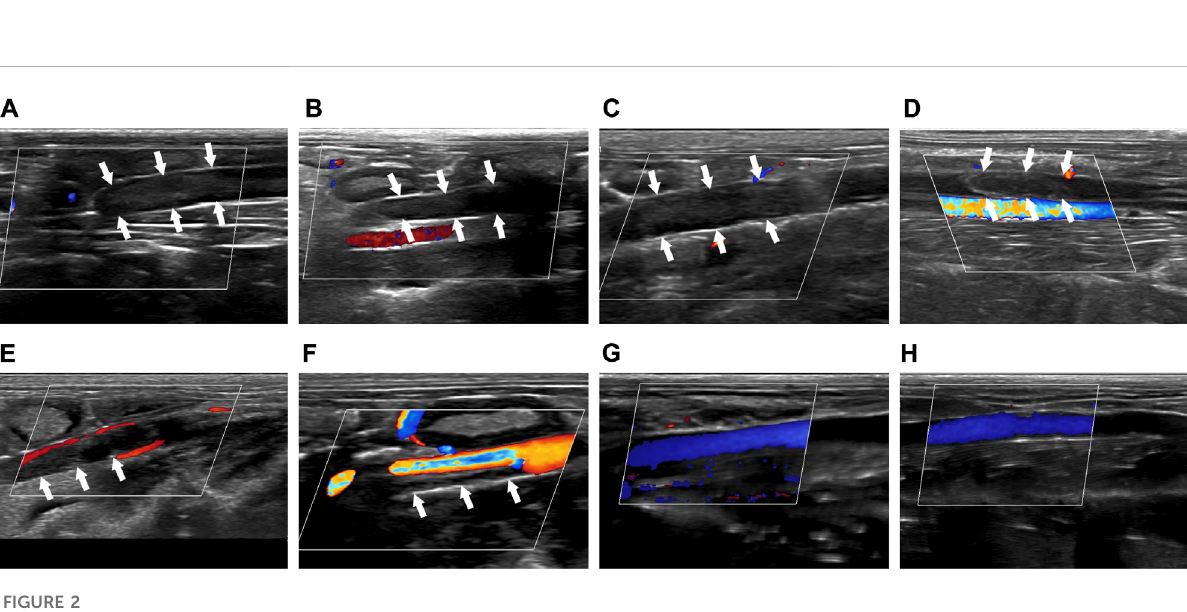
Frontiers in Bioengineering and